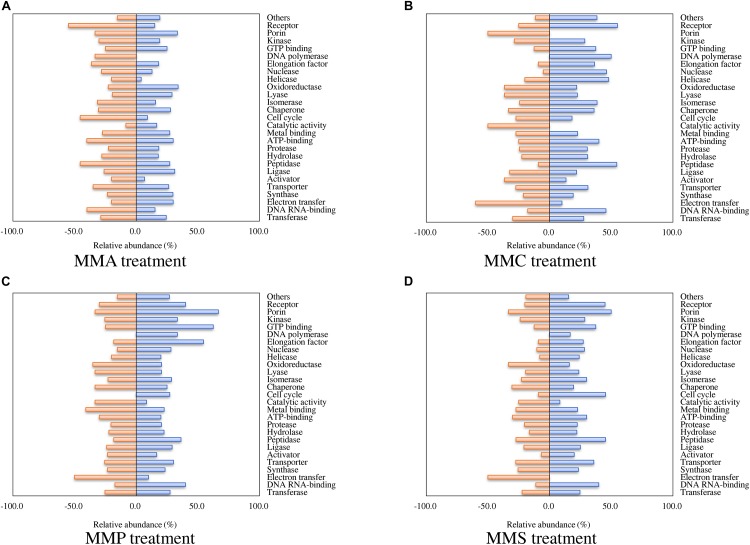
Percentage of proteins with significant fold changes in each carbon source treatment compared to LB medium. (A) MMA; (B) MMC; (C) MMP; (D) MMS. Proteins are classified by functions, and the categories with numbers less than 10 are summed up as “others.”